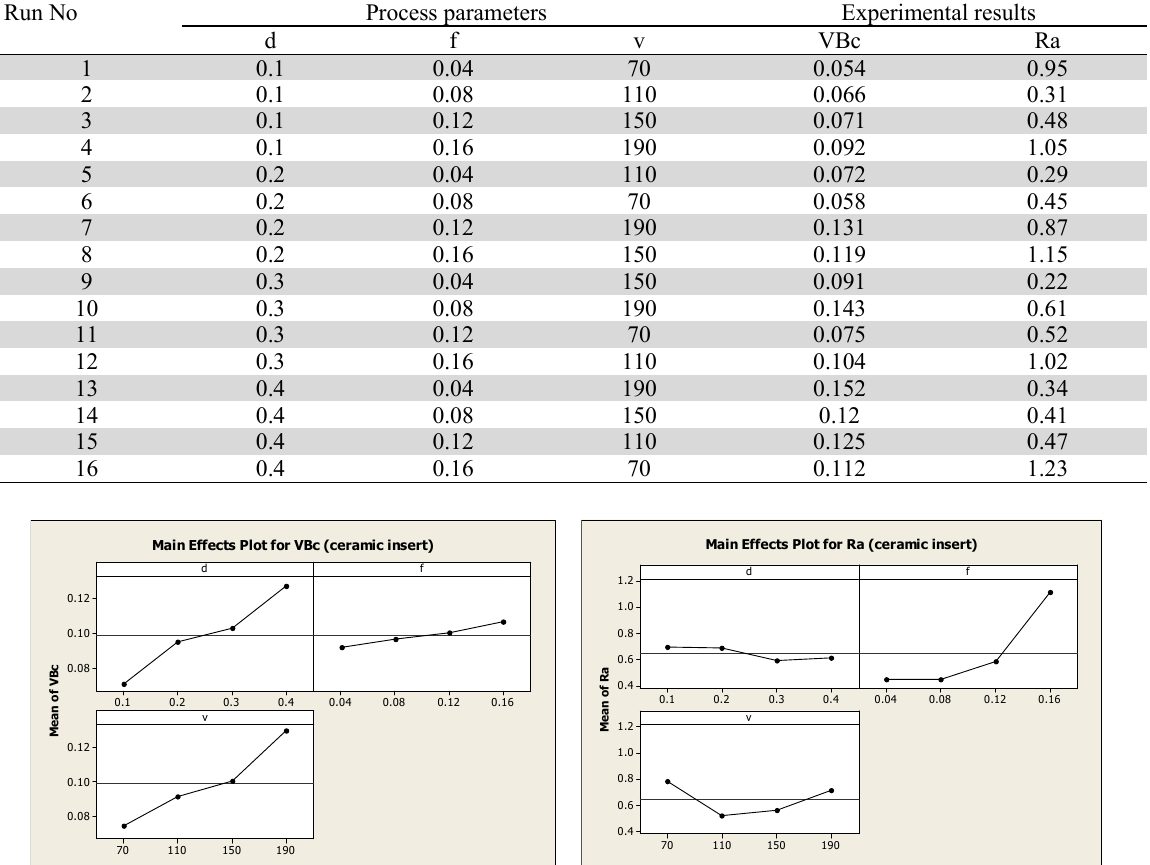
Fig. 3. Main effect plot of flank wear Fig.4. Main effect plot of surface